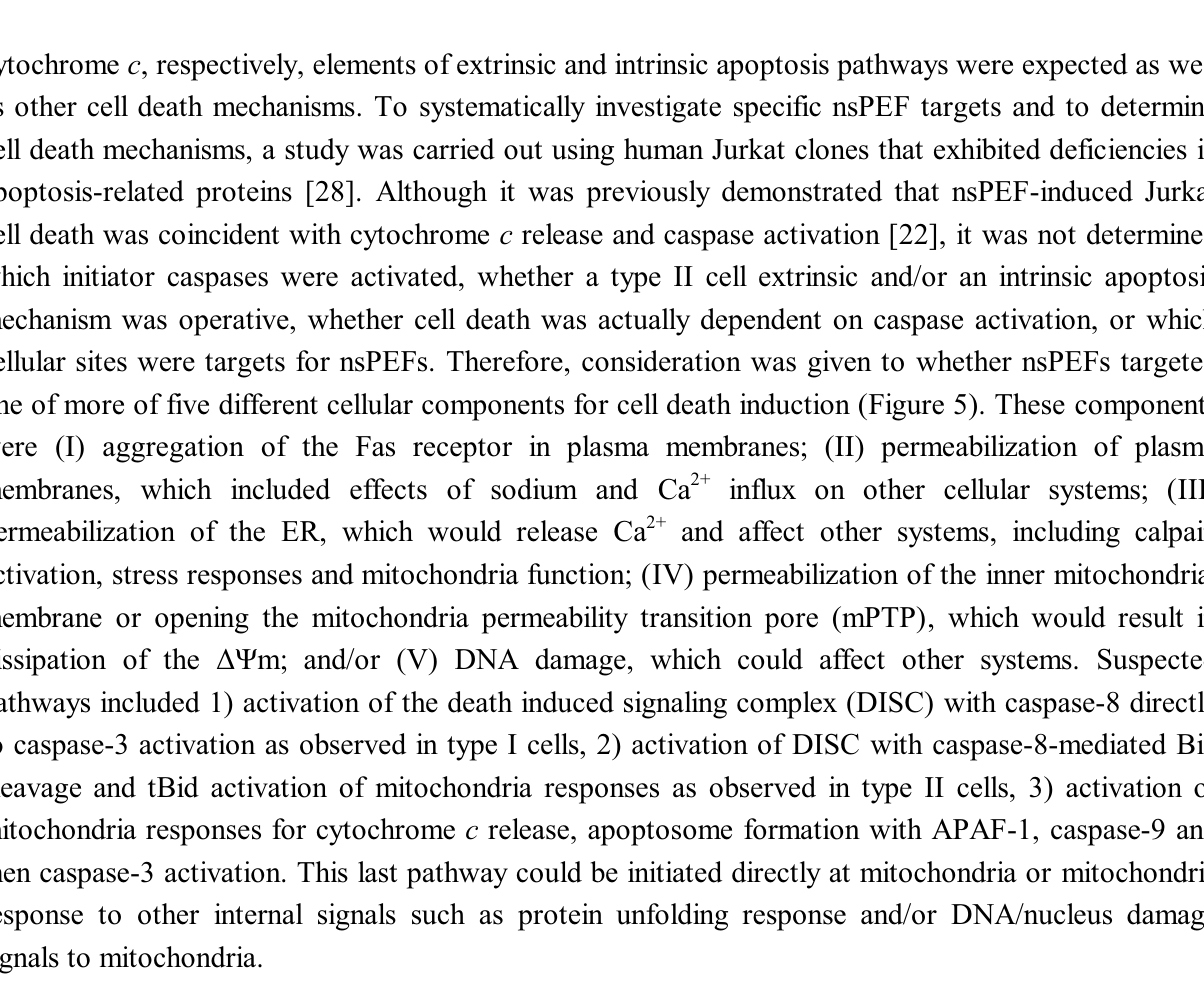
Figure 5. A model for determining nsPEF effects on cellular targets and apoptosis pathways. See text for